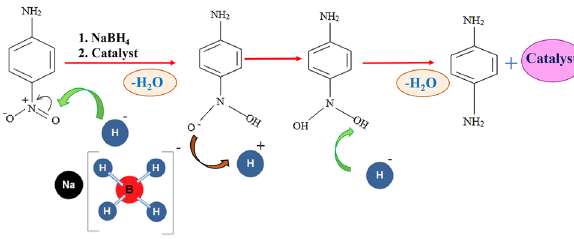
Figure 13. Mechanism of para-nitroaniline catalysed by the prepared nanocatalyst.